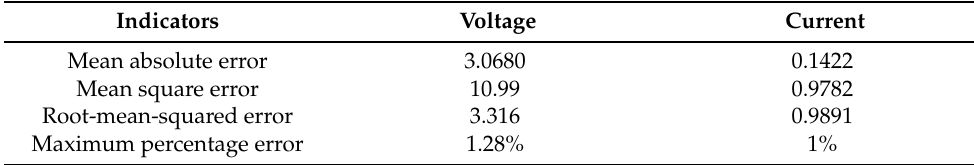
Table 8. Calculation of voltage and current